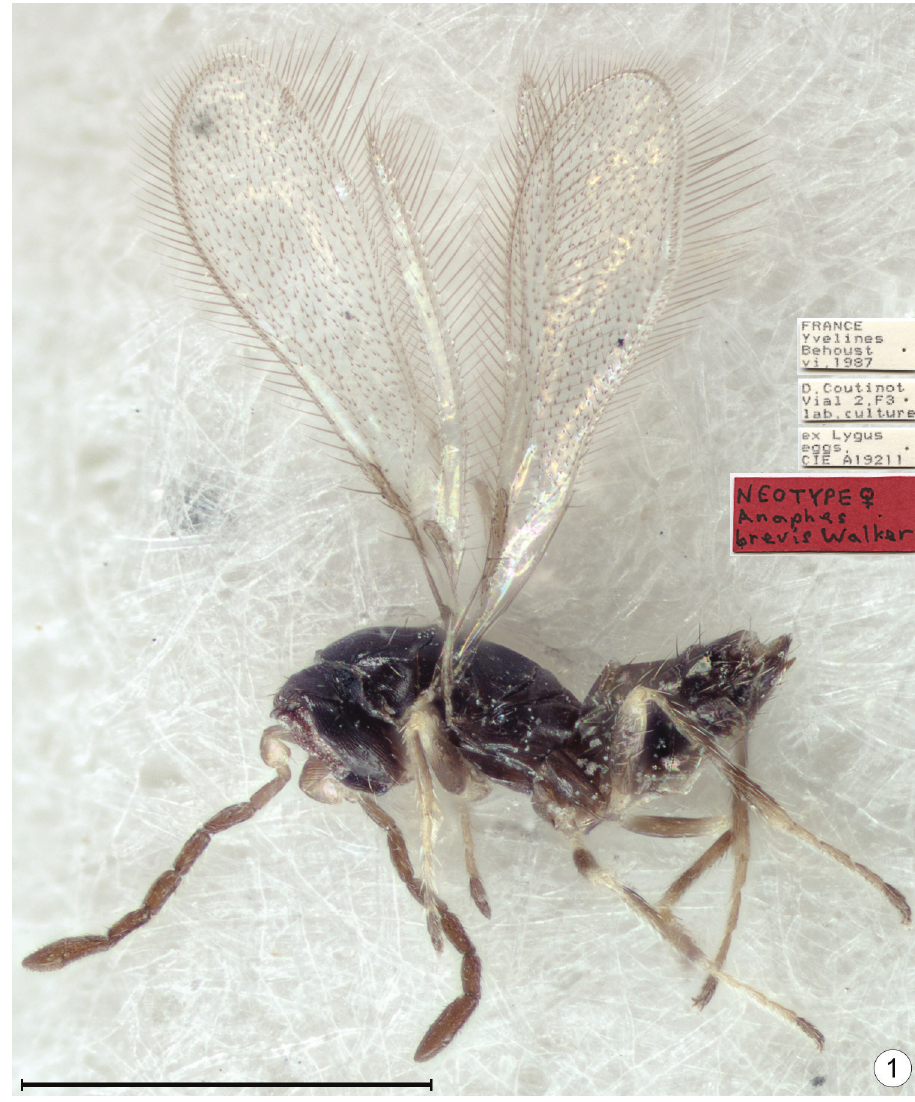
Figure 1. Anaphes brevis , neotype, habitus. Scale bar: 500 μm. wing by a noticeable gap (Figs 1, 7); ovipositor at most about 1.5 as long as metatibia, extending anteriorly under mesosoma at most to level of mesocoxa (Fig. 11). Female (neotype). Body length 645 μm. Antenna brown, with apex of scape and pedicel except narrowly along their dorsal surfaces lighter brown; body and legs dark brown (presumably black if neotype were fresh) except trochantellus and apex of femora, base and apex of tibia, and tarsomeres 1–3 white. Antenna with length